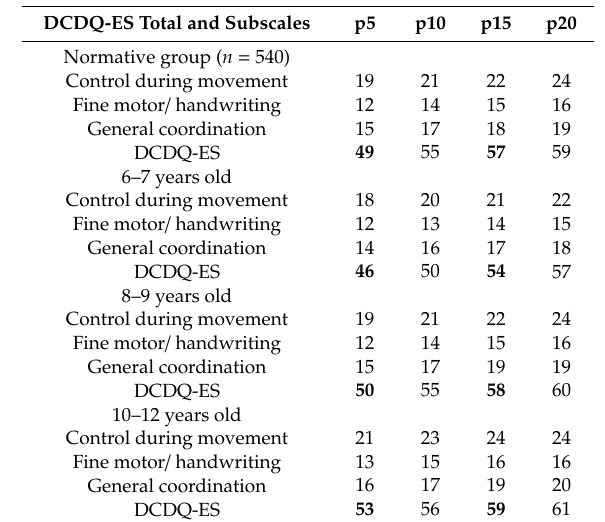
Table 3. Overall and age-specific cut-o ff points according to the 5th, 10th, 15th and 20th percentiles for the DCDQ-ES total and subscores in the normative group ( n = 540).